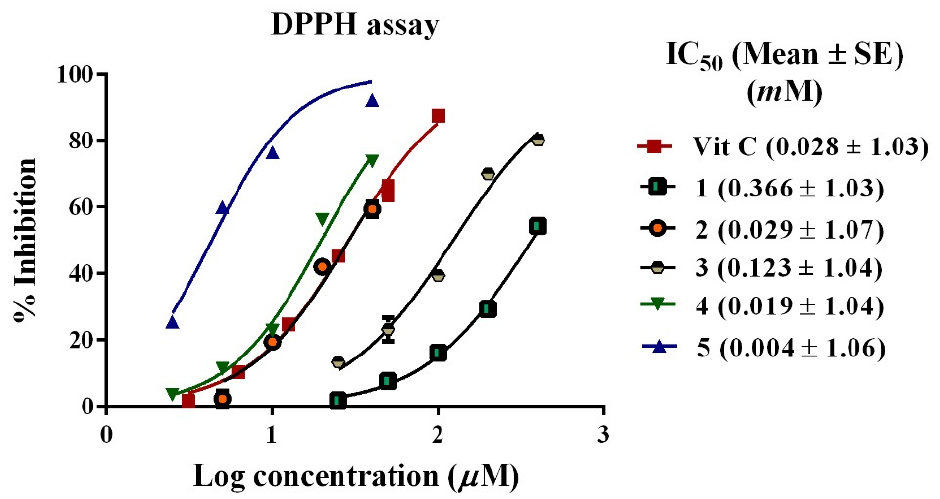
Figure 4. Inhibition of DPPH free radicle by isolated compounds ( 1–5 ) from C. oblongifolia and vitamin C.